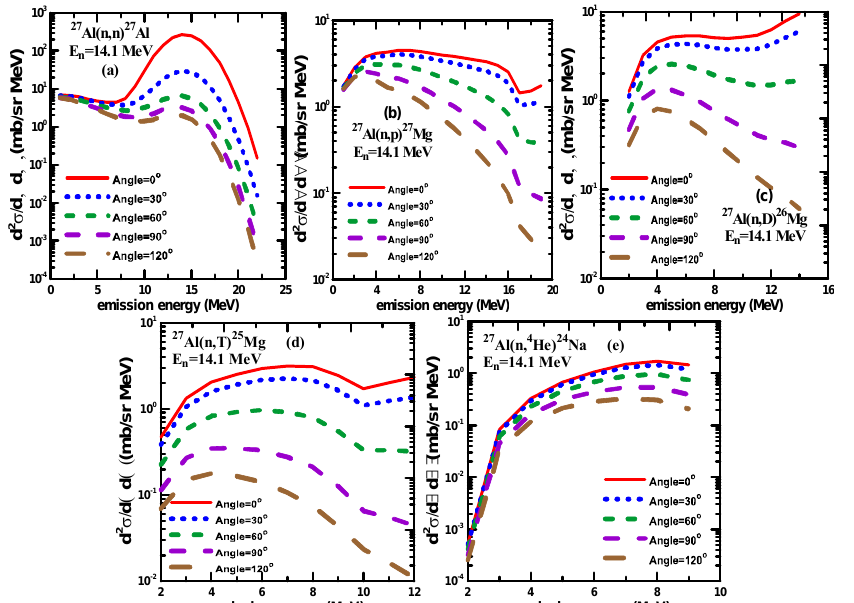
Fig. 6: The double differential cross sections of different mechanisms as a function of particle emission energy in cm-system at 60 MeV incident proton for the reactions, (a) 27 Al (n, n) 27 Al (b) 27 Al (n, p) 27 Mg (c) 27 Al (n, D) 26 Mg (d) 27 Al (n, T) 25 Mg and (e) 27 Al (n, 4 He) 24